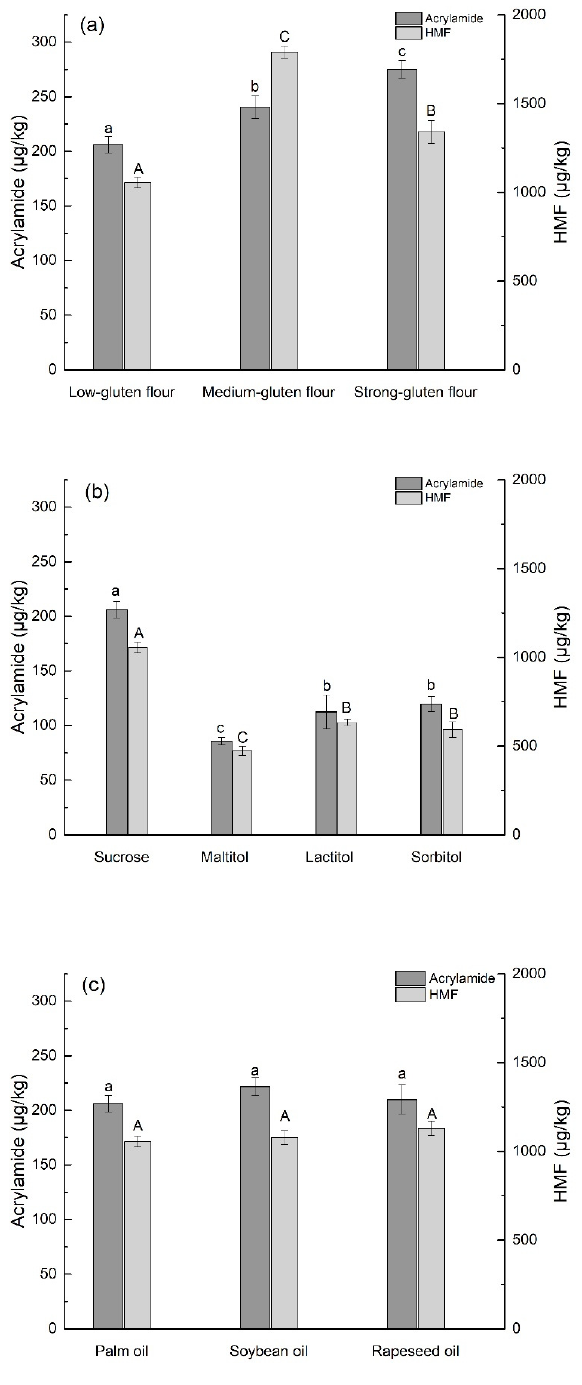
Figure 2. Effect of different ingredients (wheat flours ( a ), polyol sweeteners ( b ), and frying oil ( c )) on acrylamide and 5-hydroxymethylfurfural (HMF) in fried dough twist (FDT). The different lowercase and uppercase letters represent significant difference ( p < 0.05).